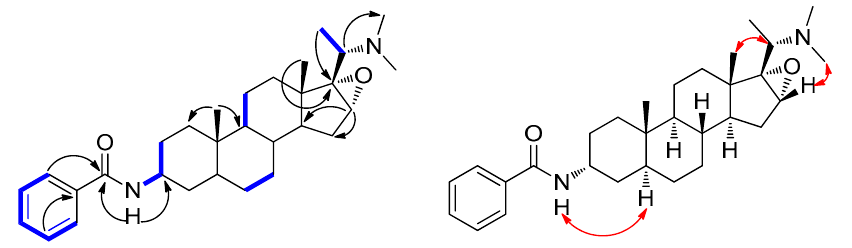
Figure 3. Key 1 H, 1 H-COSY (